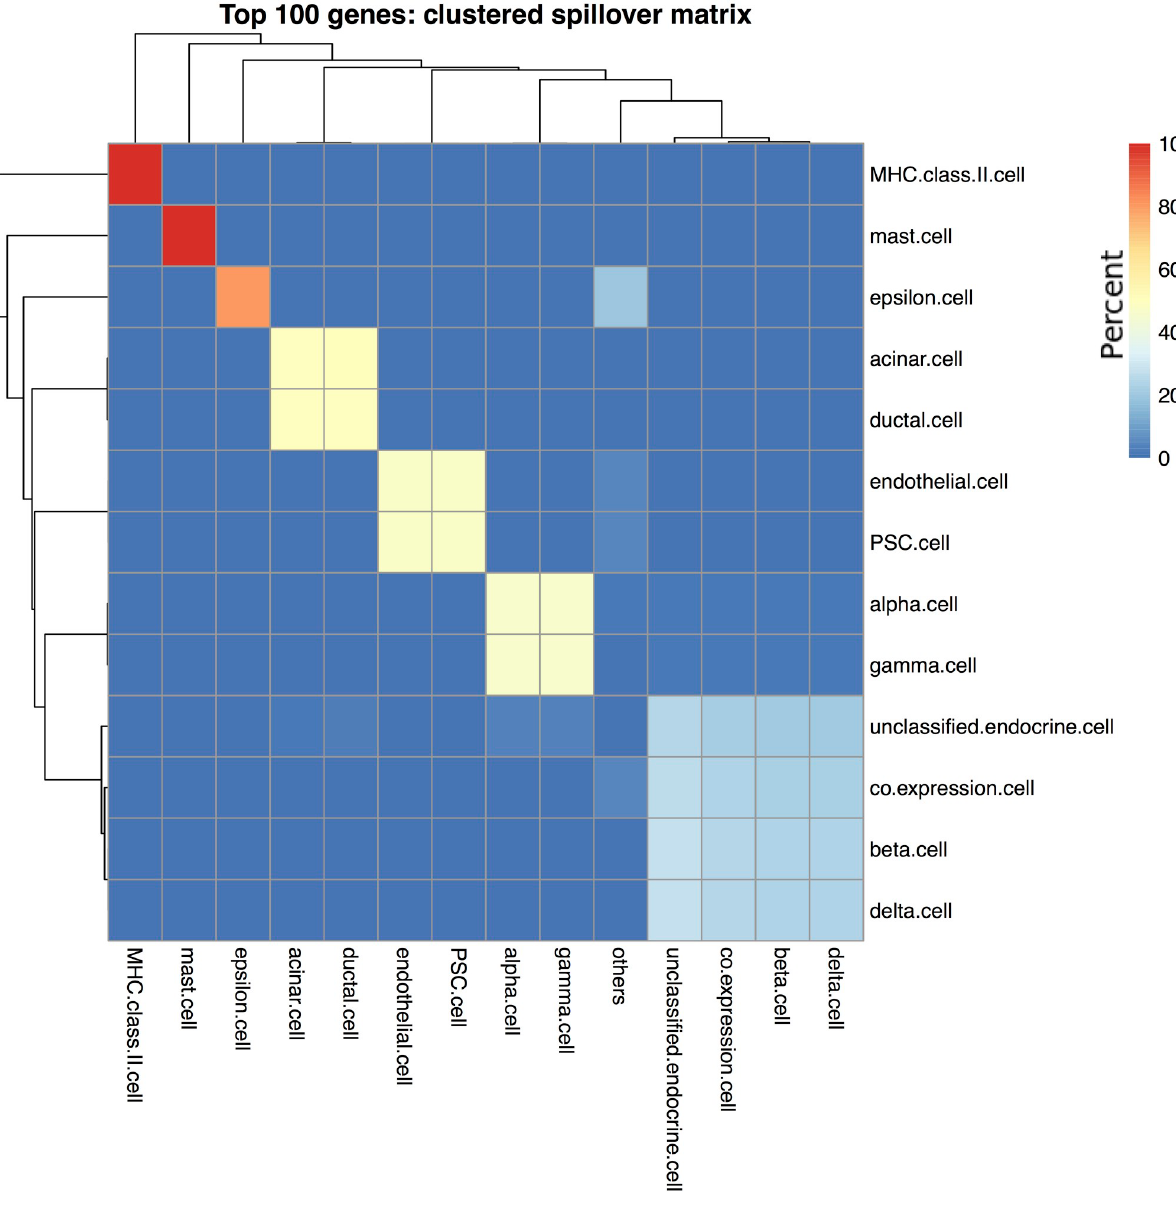
Fig 6. Clustering of Top 100 gene signature matrix. The cell type clusters identified using the signature matrix constructed from the 100 genes with the highest variance across cell types in the single cell data drawn from a normal pancreas sample. Rows show purified cell types and columns show what those samples deconvolve as. Cells are colored by percentage, such that each row adds up to